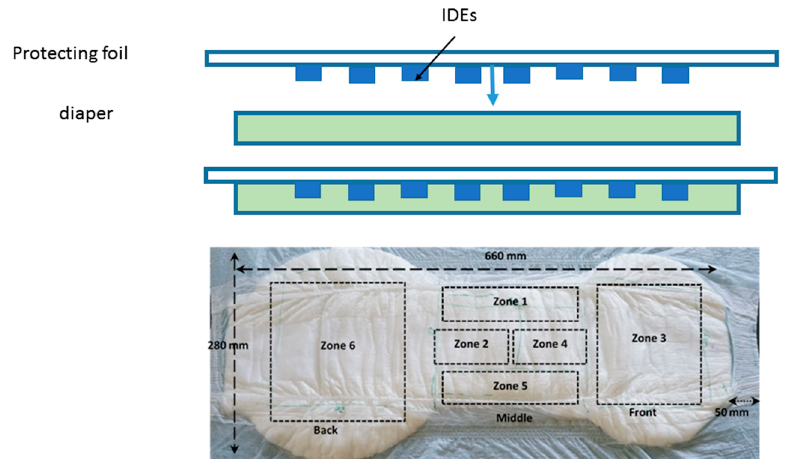
Figure 2. Integration of the novel smart incontinence sensor into standard diaper. First IDE array is realized on protecting foil by using screen printing. In the next step the foil is laminated on the bottom of the diaper. Foil and lamination are standard material and standard procedure in diaper production.